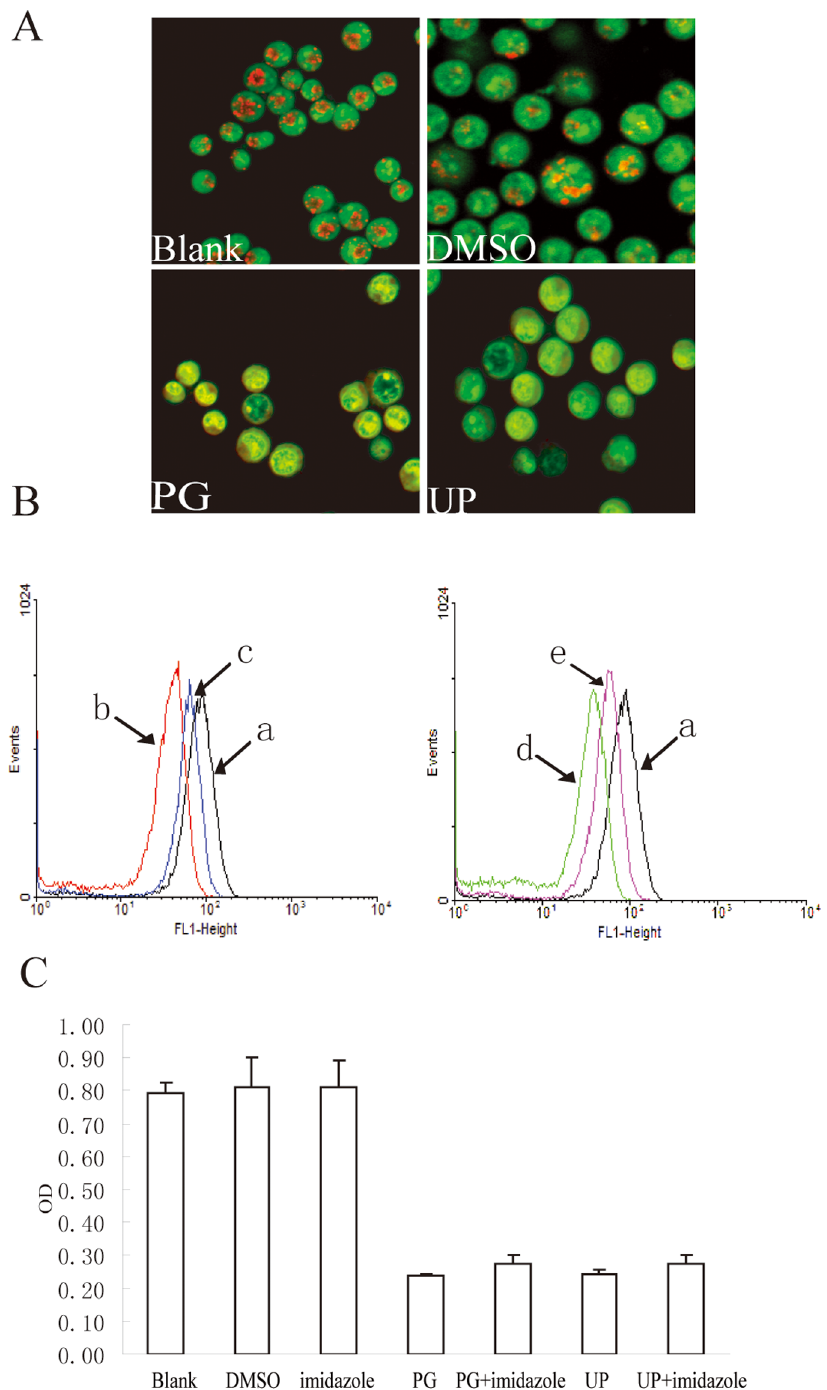
Figure 7. Acidification does not participate in UP caused growth inhibition. A. Acridine orange staining of P388 cells, PG and MP were 0.05 m M, AO was 5 m g/ml. Orange granules were acidified compartments. B. Represent data of flow-cytometric pHi analysis using 10 m M BCECF-AM staining after the cells were incubated with 0.05 m M of PG or UP for 24 h with or without imidazole (0.5 mM) pretreatment for 1 h. a, Control; b, PG; c, PG + imidazole; d, UP; e, UP + imidazole C. Effect of acidification inhibitor on UP-induced P388 growth inhibition, the cells were pretreated with imidazole (0.5 mM ) for 1 h, then co-treated with PG (0.05 m M) and UP (0.05 m M) for 72 h. doi:10.1371/journal.pone.0065381.g007 proteins were detected, amongst which 171 proteins, to our For further validation, P388 cells were incubated with UP at surprise, were ribosomal proteins with higher CoverPercent 0.05 m M for 1 h and ribosome was isolated by sucrose density (Table 1), suggesting that UP may primarily bind to ribosome. gradient fractionation. Comparing with control group where UP